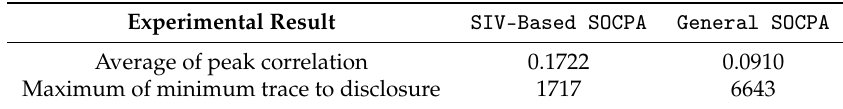
Table 5. Average peak correlation coefficient and maximum of minimum trace to disclosure of two versions of SOCPA on MixColumns